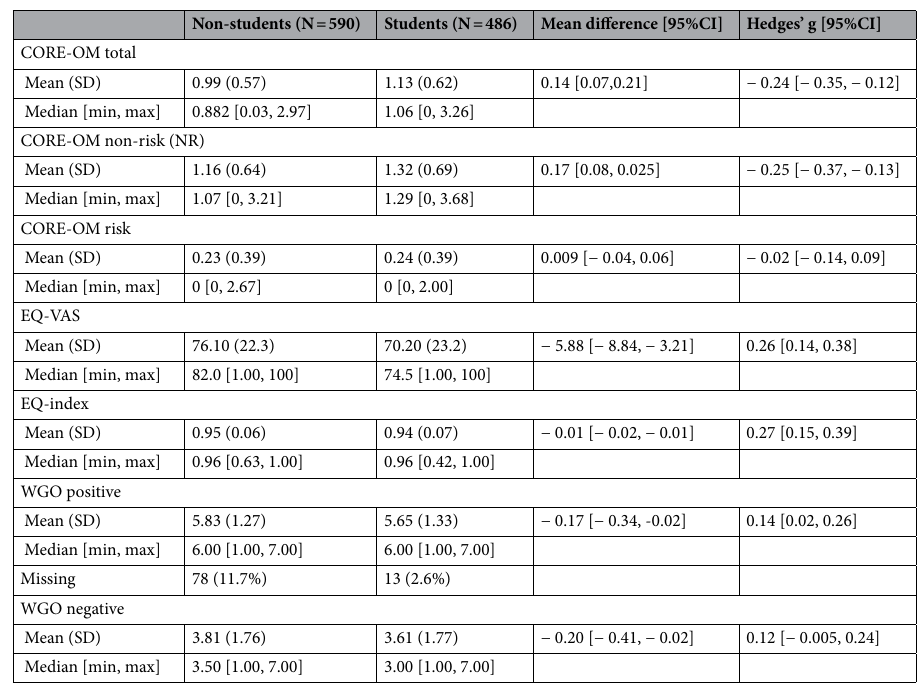
Table 2. Mean, SD, distribution of the dependent variables by group and mean difference and effect sizes (Hedges’ g) of the comparison between groups. CORE-OM Clinical Outcomes in Routine Evaluation, NR Non- risk items score, EQ-Index EuroQol five-dimension-three-level Index, EQ-VAS EuroQol Visual Analogue Scale, WGO+ve What’s Going On score for “good things happened to me these last two months”, WGO−ve What’s Going On score for “bad things happened to me these last two